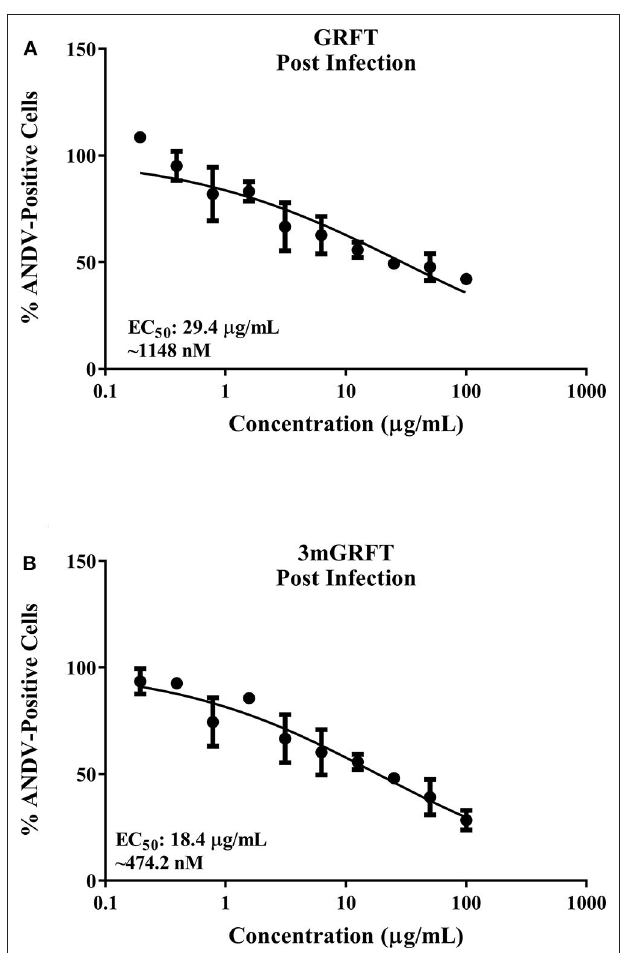
FIGURE 2 | GRFT and 3mGRFT minimally affect post viral entry steps. Vero-E6 cells were infected with ANDV at MOI of 0.2 for 2h at 37 ◦ C. Cells were then treated with varying concentrations of GRFT (A) or 3mGRFT (B) . At 72h post infection, cells were fixed, stained, and analyzed as in Figure 1B . Dose-response curve shows quantitation of ANDV-infected cells treated with GRFT (A) or 3mGRFT (B) (% normalized to vehicle-only control). Graphs represent the mean ± SD and are representative of three independent experiments, performed in quadruplicate.